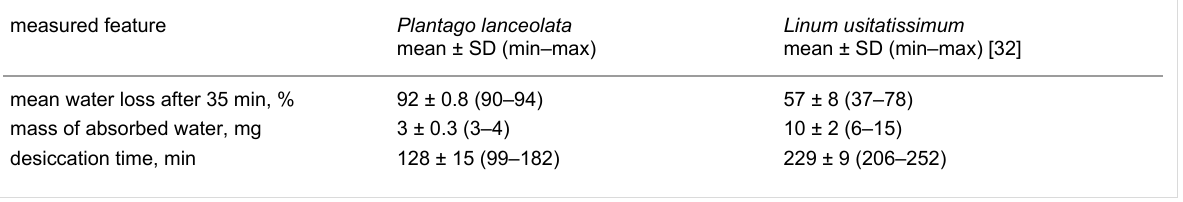
Table 2: Comparison of desiccation data for Plantago lanceolata (cellulose mucilage) and Linum usitatissimum (pectic mucilage). measured feature